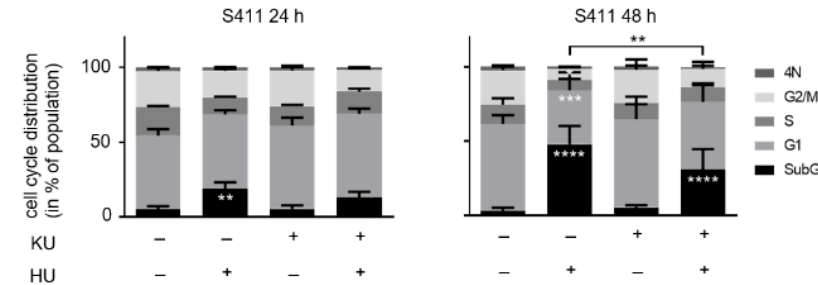
Figure 4. Flow cytometry data showing the impact of hydroxyurea and KU-60019 on cell cycle progression and apoptosis-associated DNA fragmentation. ( A ) The PDAC cell lines S821, 8296, 8248, and S411 were treated with 5 µM entinostat ± 1mM hydroxyurea for 24 h. PR130 as well as the phosphorylation of KAP1 were measured by immunodetection; HSP90 as loading control; n = 3. ( B – E ) The cells were treated with 1 mM hydroxyurea (HU) ± 5 µM KU-60019 (KU) for 24 h and 48 h; n = 3. Flow cytometry was carried out to measure cell cycle distributions and subG1 phase cells. Statistical analysis was done with two-way ANOVA (* p < 0.05, ** p < 0.01, *** p < 0.001, **** p < 0.0001).